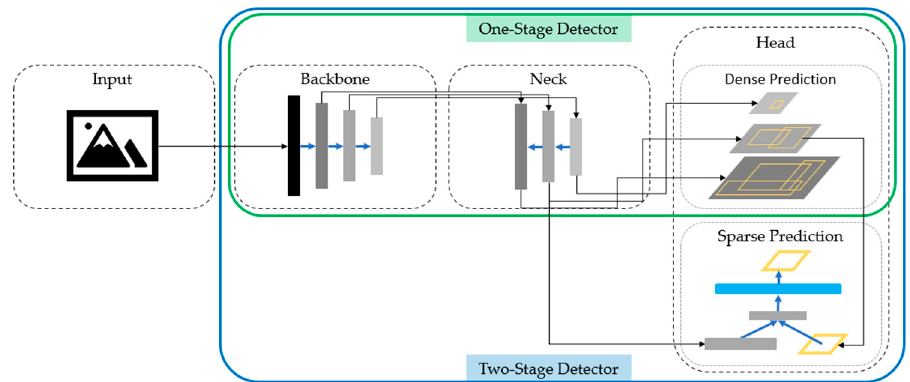
Figure 1. Object detector architecture.